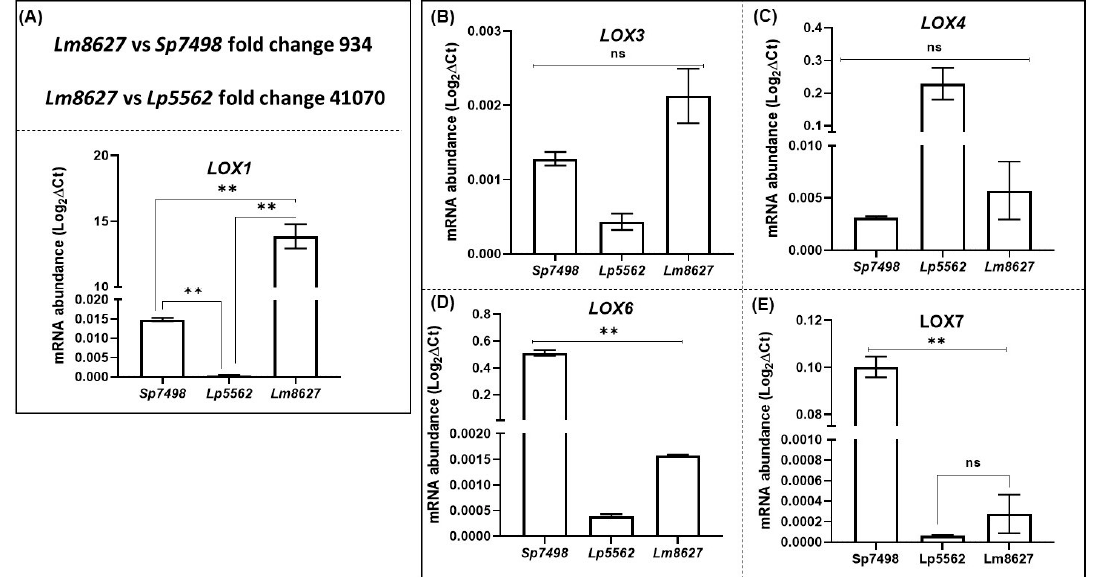
Figure 6. Comparative qRT-PCR analysis of LOX genes in Spirodela polyrhiza 7498 , Lemna minor 8627 , and Landoltia punctata 5562 . Plants were taken for expression analysis at different ages of culture. All cultures were grown for 28 days in nutrient solution and samples were collected at 14, 21, and 28 days of growth. The SpACT and Sp18SrRNA housekeeping genes were used to normalize the expression of LOX genes, as described in Materials and Methods. ( A ) LOX1 , ( B ) LOX3 , ( C ) LOX4 , ( D ) LOX6 , and ( E ) LOX7 expression comparison was made among the three strains. ANOVA with Dunnett’s multiple comparisons test was performed for significant differences in LOX gene expression in the aging tissues among the duckweed species. Statistical significance between aging expression data points was assessed against the 14-day expression profiles and categorized as ** p < 0.01, using Graph Pad (version 8.0); ns: not significant.